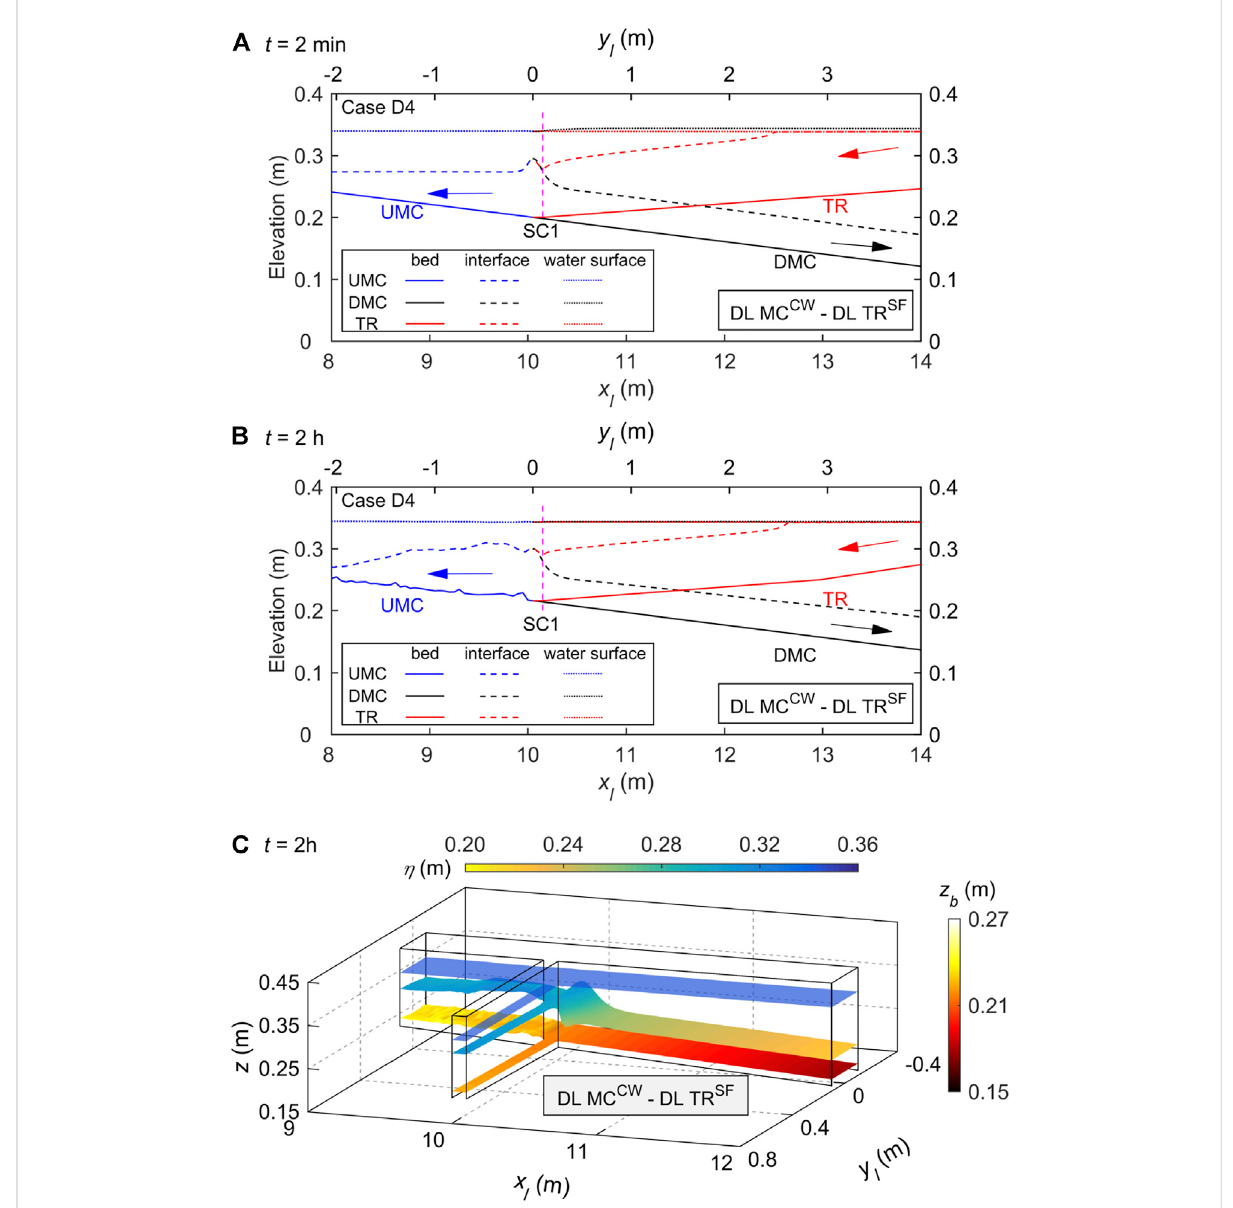
CaseD4ofDLMC CW — DLTR SF forclear-water fl owinthemainchannel(MC)andhighlyconcentrated,sediment-laden fl owinthetributary(TR), where UMC and DMC denote upstream and downstream of the MC con fl uence: free water surface elevation, interface, and bed elevation pro fi